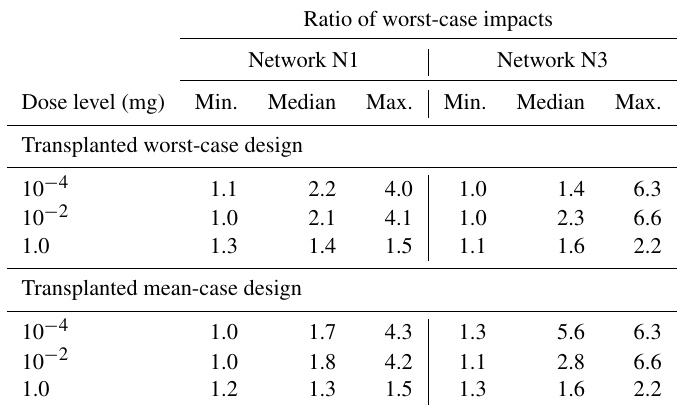
Table 3. Ratios of worst-case impacts obtained with transplanted and original CWS designs. Ratio refers to the ratio of the worst-case impact obtained with the transplanted design divided by the worst-case impact obtained with the worst-case design developed using the original network model. Minimum (Min.), median, and maximum (Max.) values for the ratio are given for the nine ratios determined for the three sensor set sizes and the three